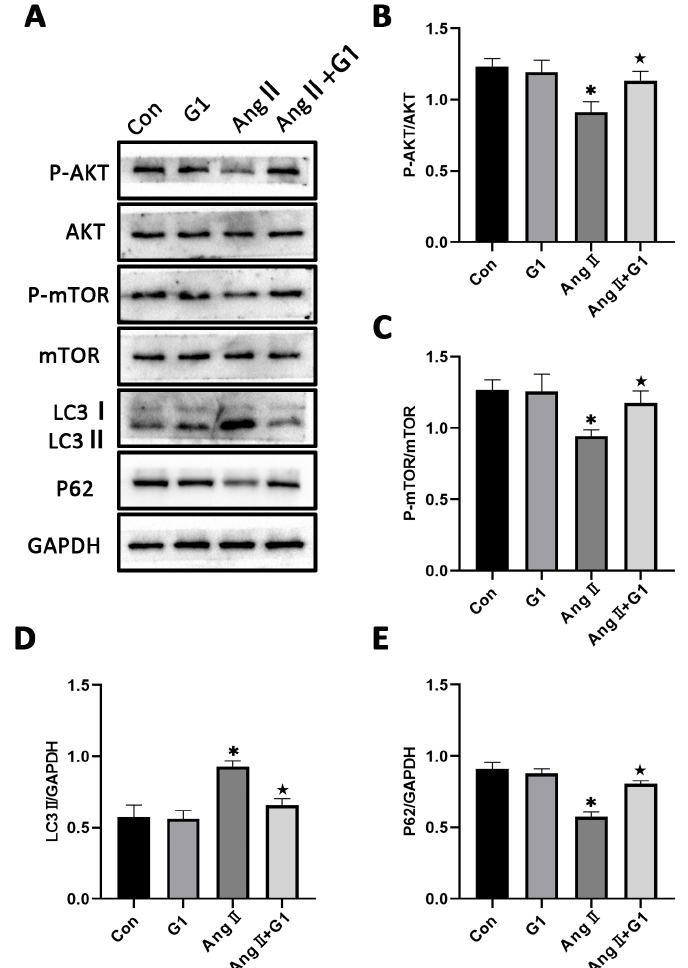
Figure 7. The Akt/mTOR pathway and autophagy were involved in G1 alleviating AngII-induced hypertrophy of H9c2 cells. ( A ) Representative images of Western blots in the Con, G1, AngII and AngII + G1 groups. ( B ) p-AKT/AKT ratios, ( C ) p-mTOR/mTOR ratios, ( D ) LC3II/GAPDH, ( E ) P62/GAPDH from indicated groups. The data is expressed as mean ± SEM and was analyzed by one-way ANOVA (n = 3). * p < 0.05 vs. Con; (cid:70) p < 0.05 vs. ★